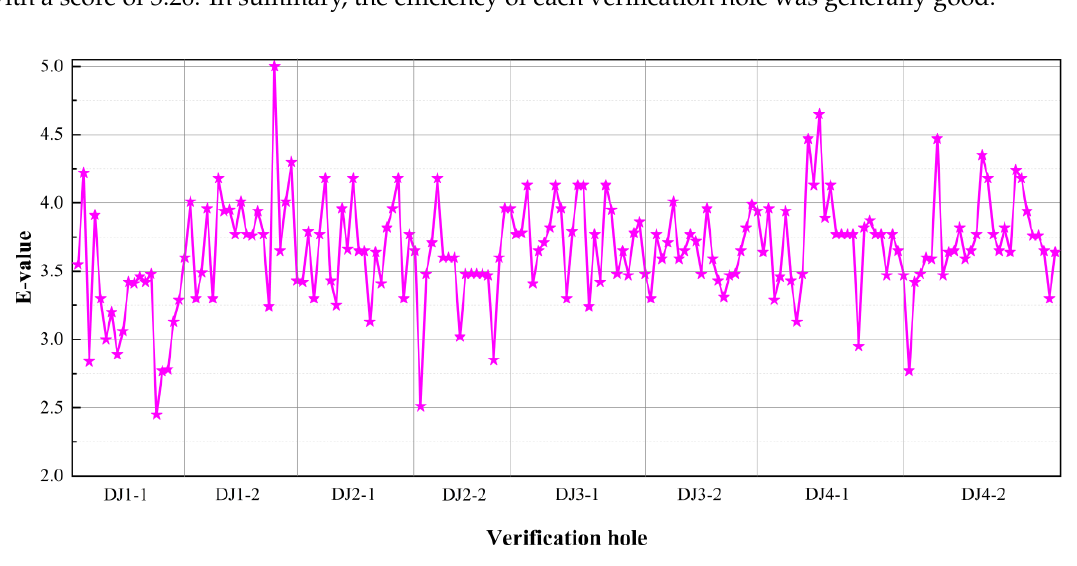
Figure 11. Comprehensive evaluation index E of each verification hole.